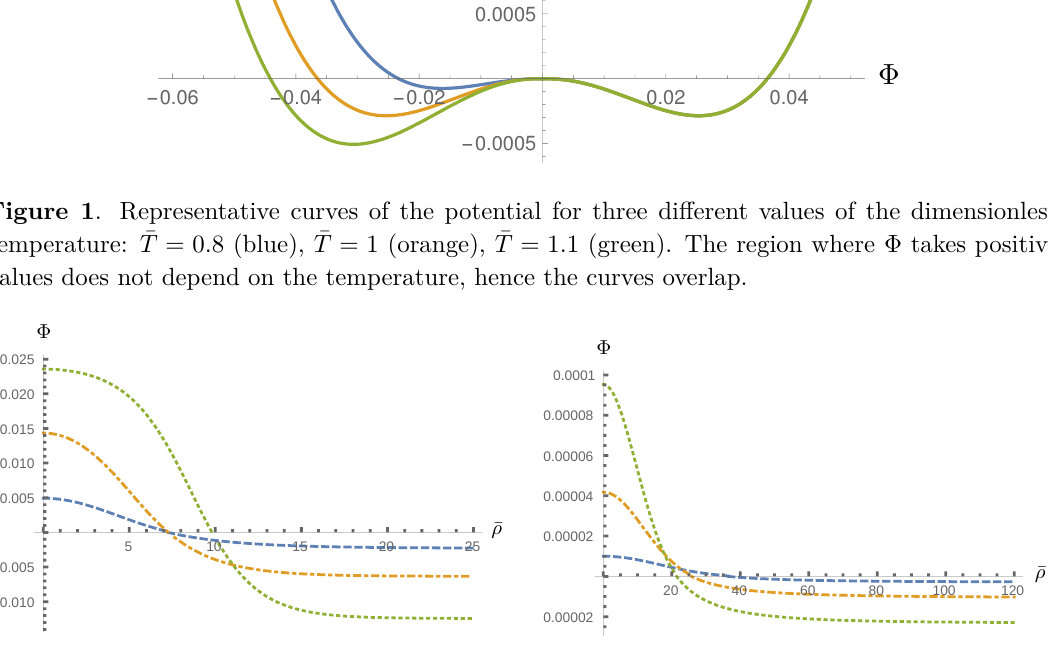
Figure 2 . Solutions for the bubble profile in the O(3) case (left) with ¯ T = 0 . 3 (dashed), 0.5 (dash- dotted), 0 . 7 (dotted) and in the O(4) case (right) with ¯ T = 0 . 01 (dashed), 0.02 (dash-dotted), 0 . 03